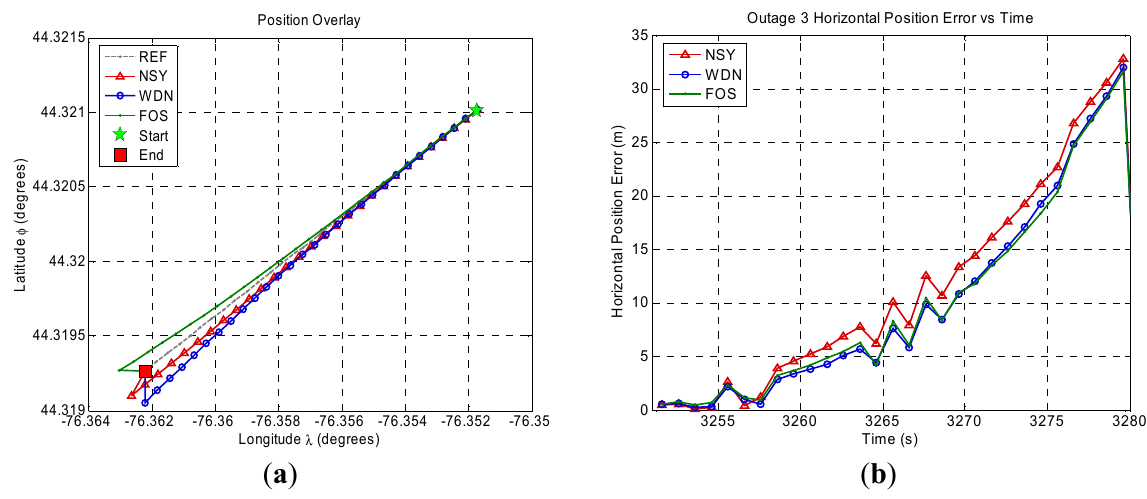
Figure 10. Land vehicle experiment position domain results for GPS outage 3. ( a ) Position domain plot. ( b ) Horizontal position error plot.